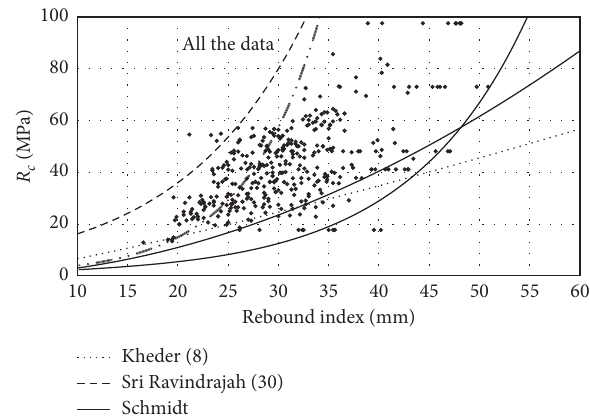
Figure 16: The whole set of experimental data compared to the calibration curves of this paper, the Schmidt curve, and the curves obtained in [8,